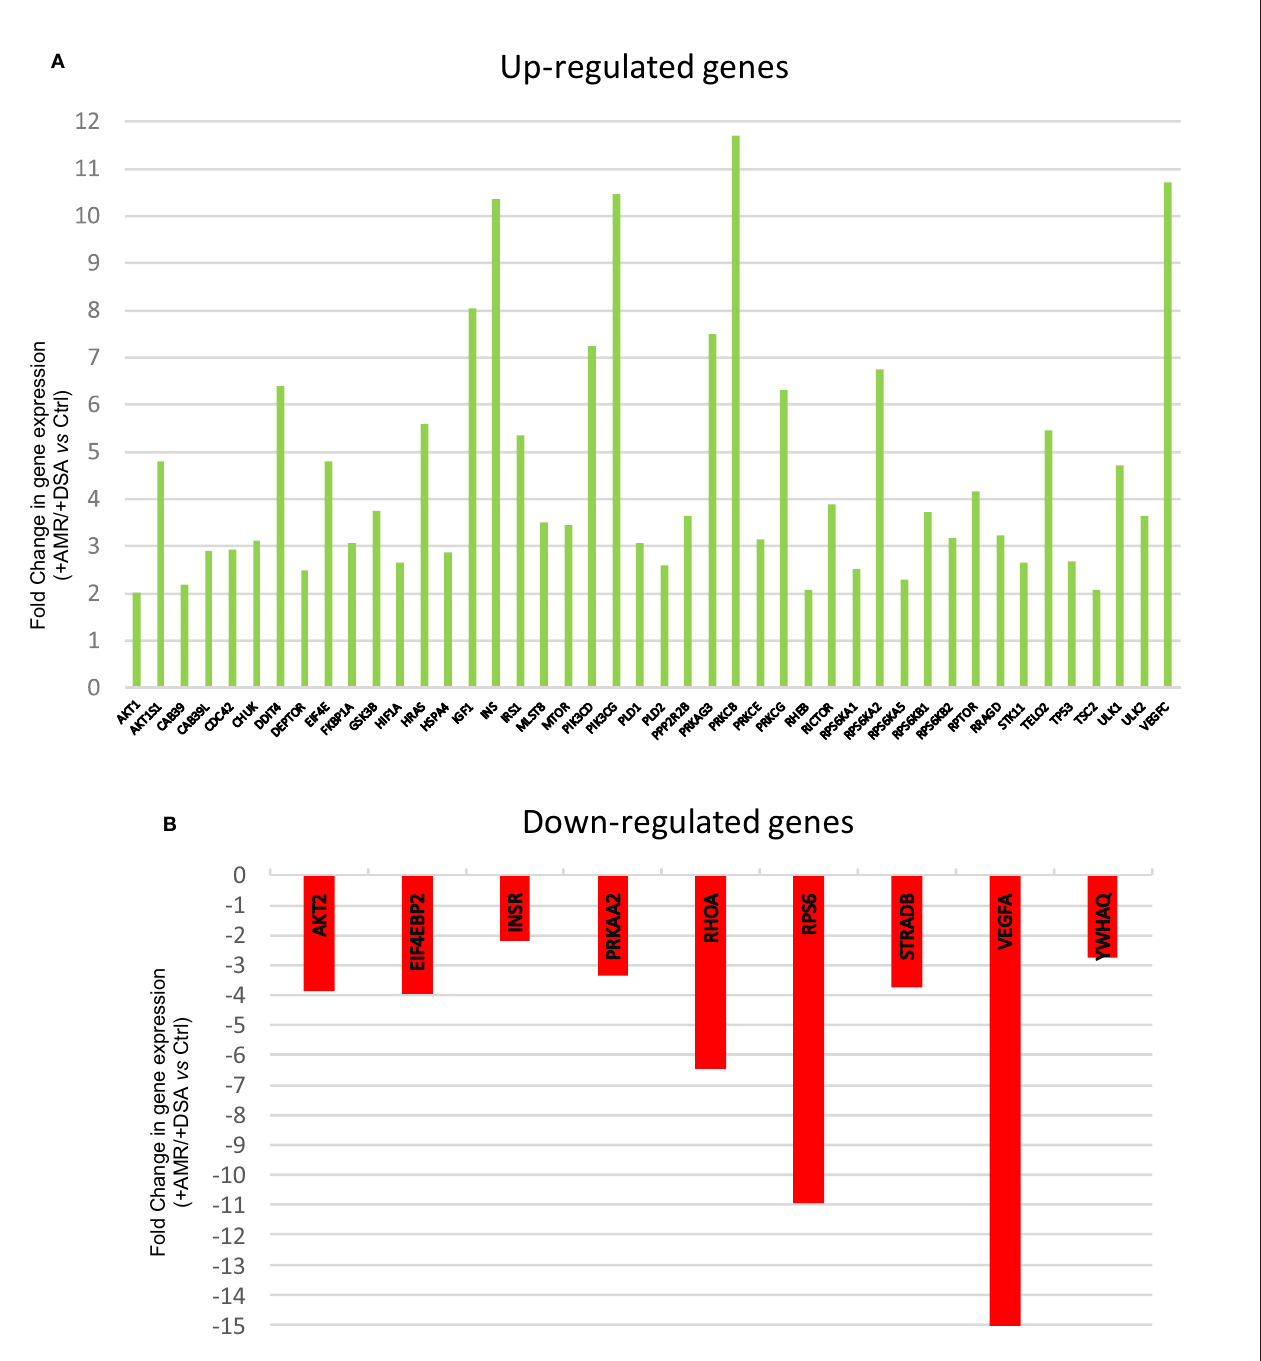
FIGURE 1 | Differentially regulated mTOR pathway genes. (A) Up-regulated mTOR pathway genes (B) Down-regulated mTOR pathway genes.